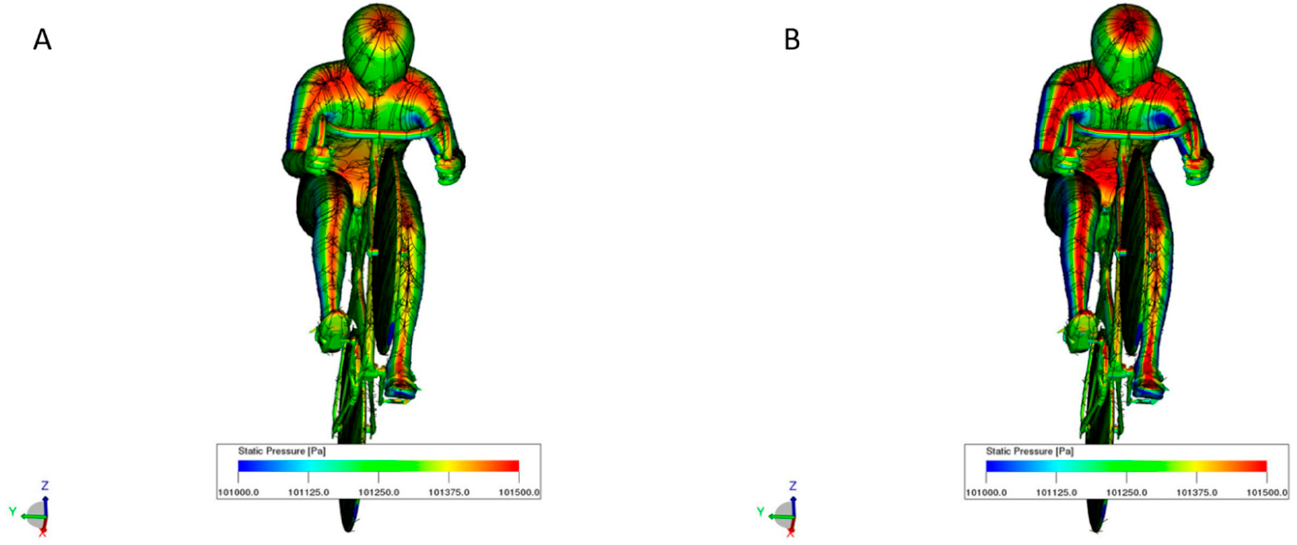
Figure 7. Time-averaged surface pressure distribution (contour and flow lines) seen from diagonally forward right, ( A ) represents the model at 16 m/s and ( B ) at 20 m/s.